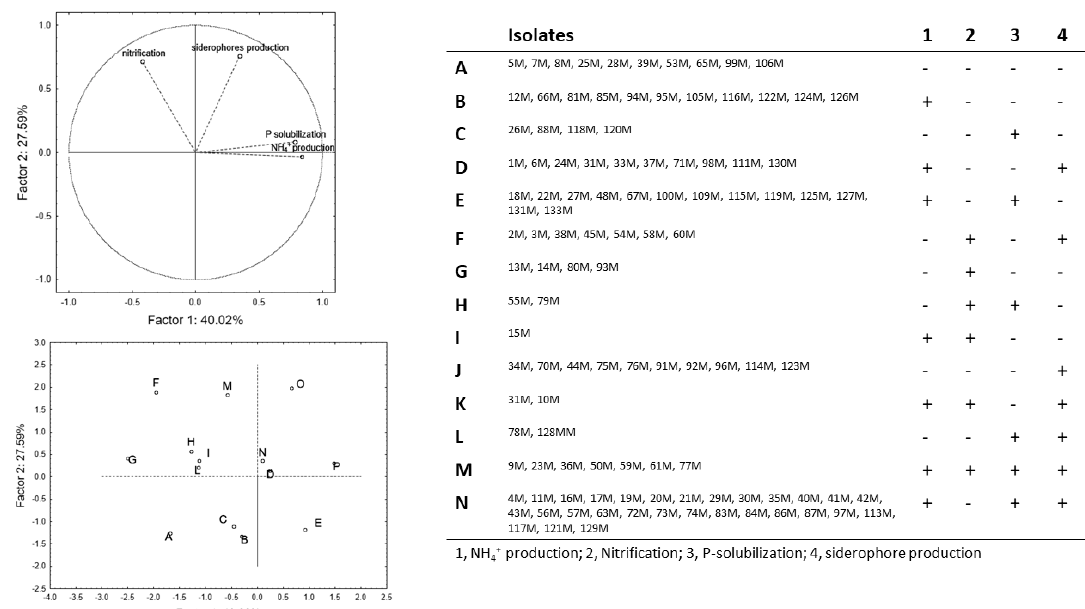
Figure 2. Principal component analysis run on the output to NH 4 + production, nitrification, P-solubilization, and siderophores production for the mesophilic bacteria.